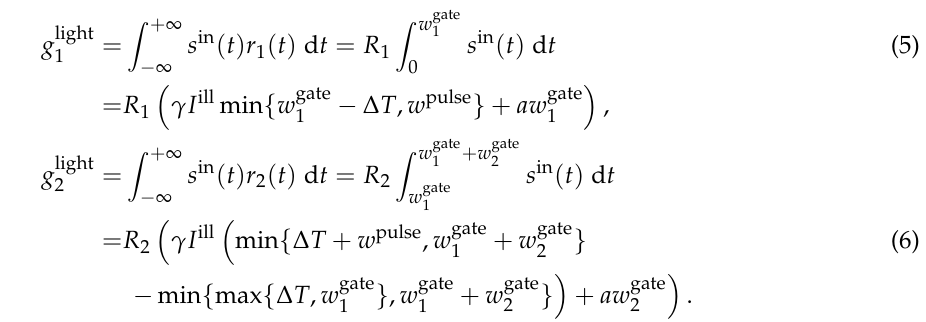
Figure 3. Pulse Based Camera Parameter Choices. ( a ) When w gate shrinks, as case 1 and case 2 cannot be distinguished; ( b ) When w gate not change proportional to the distance. The time shift between case 1 and case 2 is the same as in Figure 3c, but the ratio does not change by the same factor; ( c ) See ( b ); ( d ) For w gate gate width relates to the maximum measurable